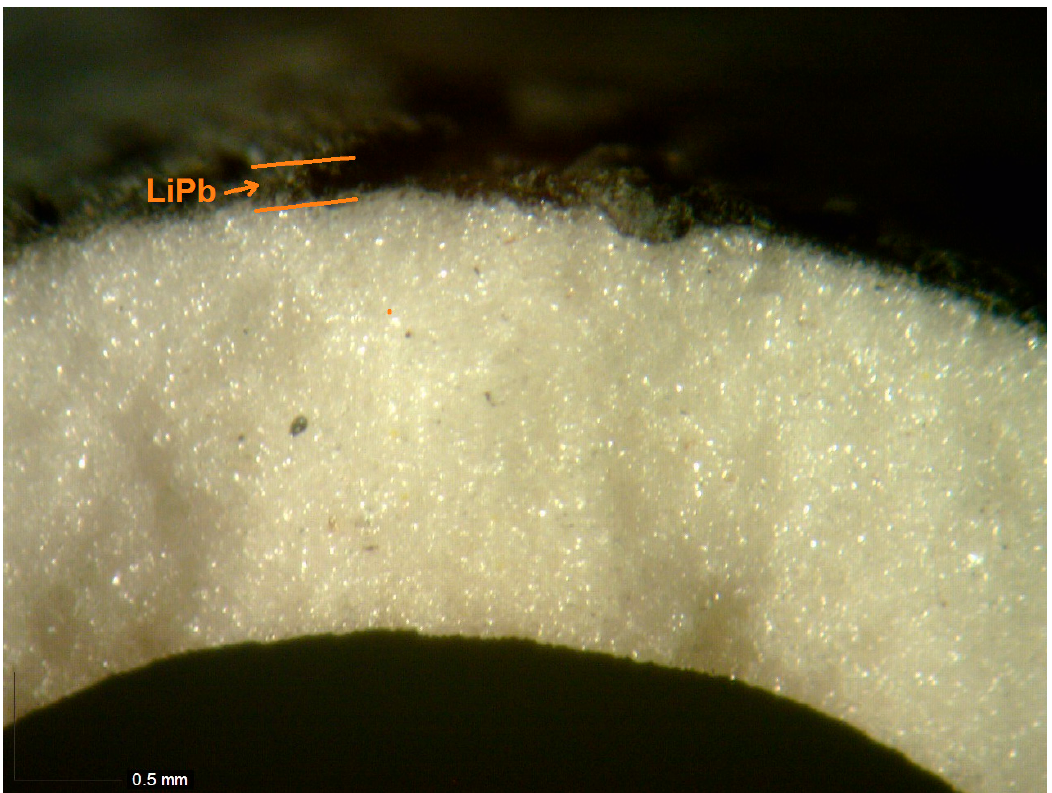
Figure 7. View (100×) of the cross-section of a porous ceramic membrane after immersion in LiPb at Figure 7. View (100 × ) of the cross-section of a porous ceramic membrane after immersion in LiPb at 450 °C. 450 ◦